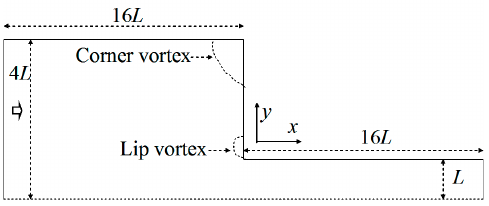
Figure 6. A diagram of the planar 4:1 contraction flow.